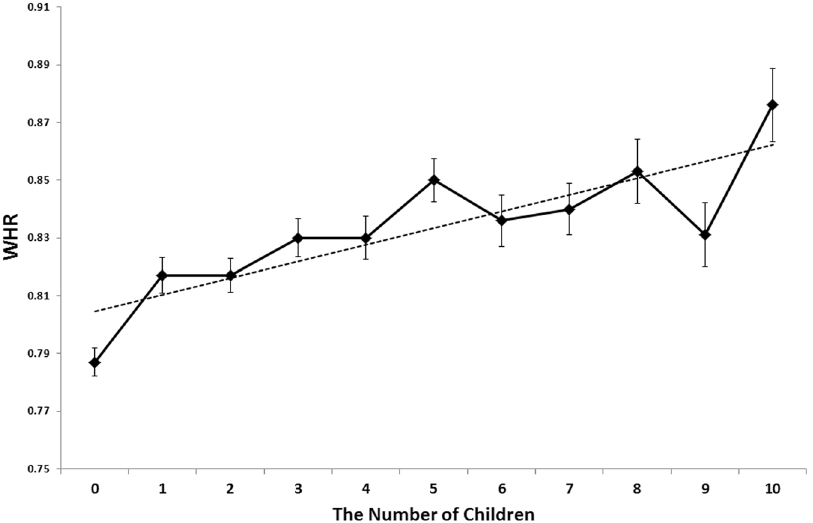
Figure 1. The Relationship between the Number of Children and the WHR (BMI, age and ethnicity are